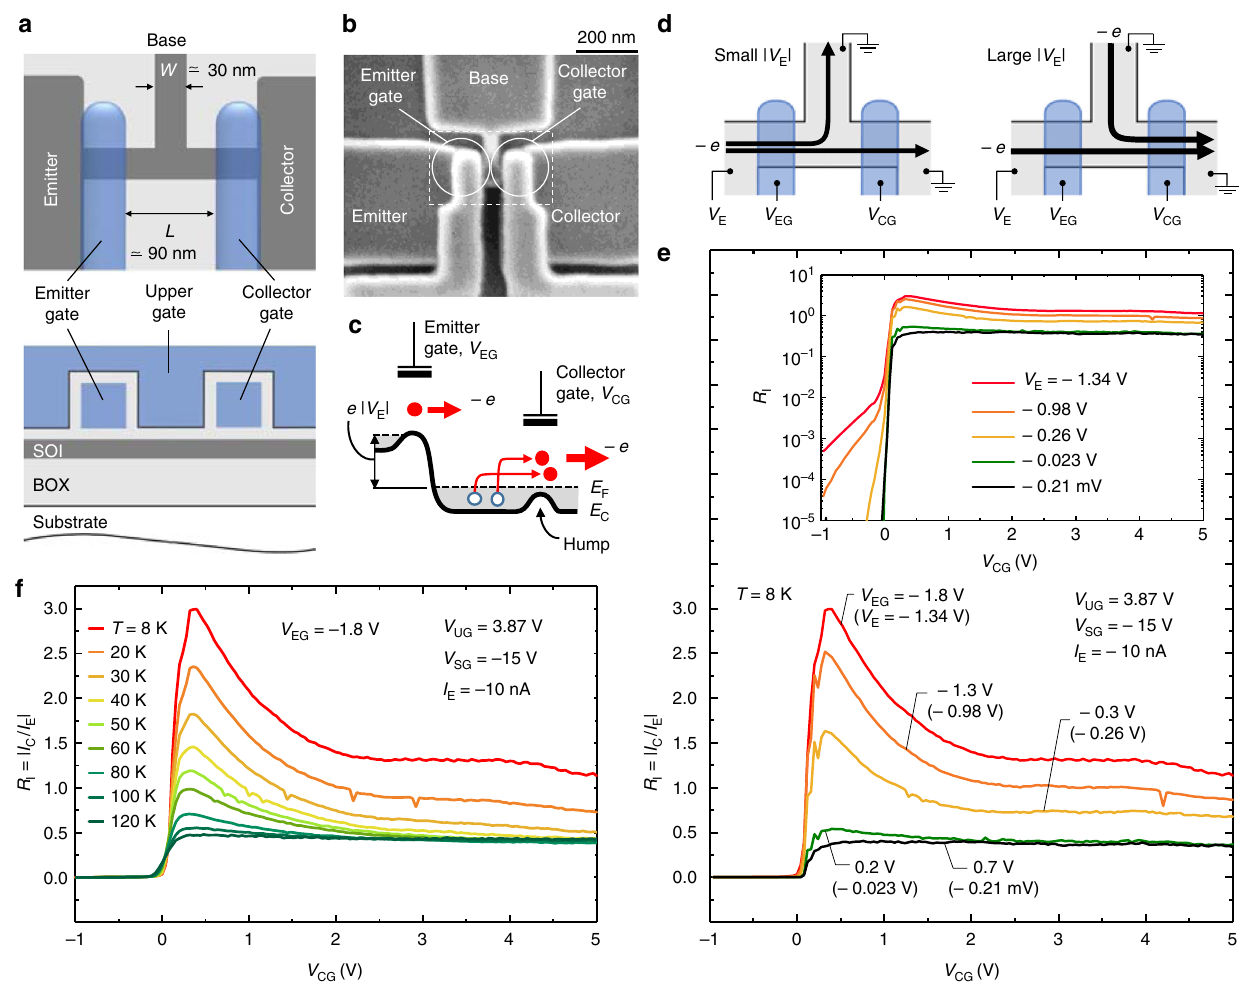
Fig. 1 Structure and enhancement characteristics of the device. a Schematic top and cross-sectional views of the device. The front and back (buried) oxides, and the SOI are 20-nm, 390-nm, and 18-nm thick, respectively. The Si channel width W in the T-branch region is about 30 nm. The length of the emitter and collector gates are about 60 nm and the spacing between the two gates L , which is an important parameter in the present study, is about 90 nm. b Scanning electron microscope image of a sample device with the same structure 26,27 as those measured here (before the upper-gate formation). Note that the Si channel and the gates are covered by oxide, and thus their actual widths are narrower than the appearance in the image. c Energy diagram of the device. E F and E C are the Fermi energy and the conduction band edge, respectively. Open blue dots represent holes. d Electron fl ow at small | V E | (left) and large | V E | (right). The arrows indicate the direction of the electron fl ow. e R I ( = | I C / I E |) as a function of the collector gate voltage V CG measured at 8 K. Inset shows the log-scale plot of the R I . f R I as a function of V CG for the emitter-gate voltage V EG = – 1.8 V using the temperature T as